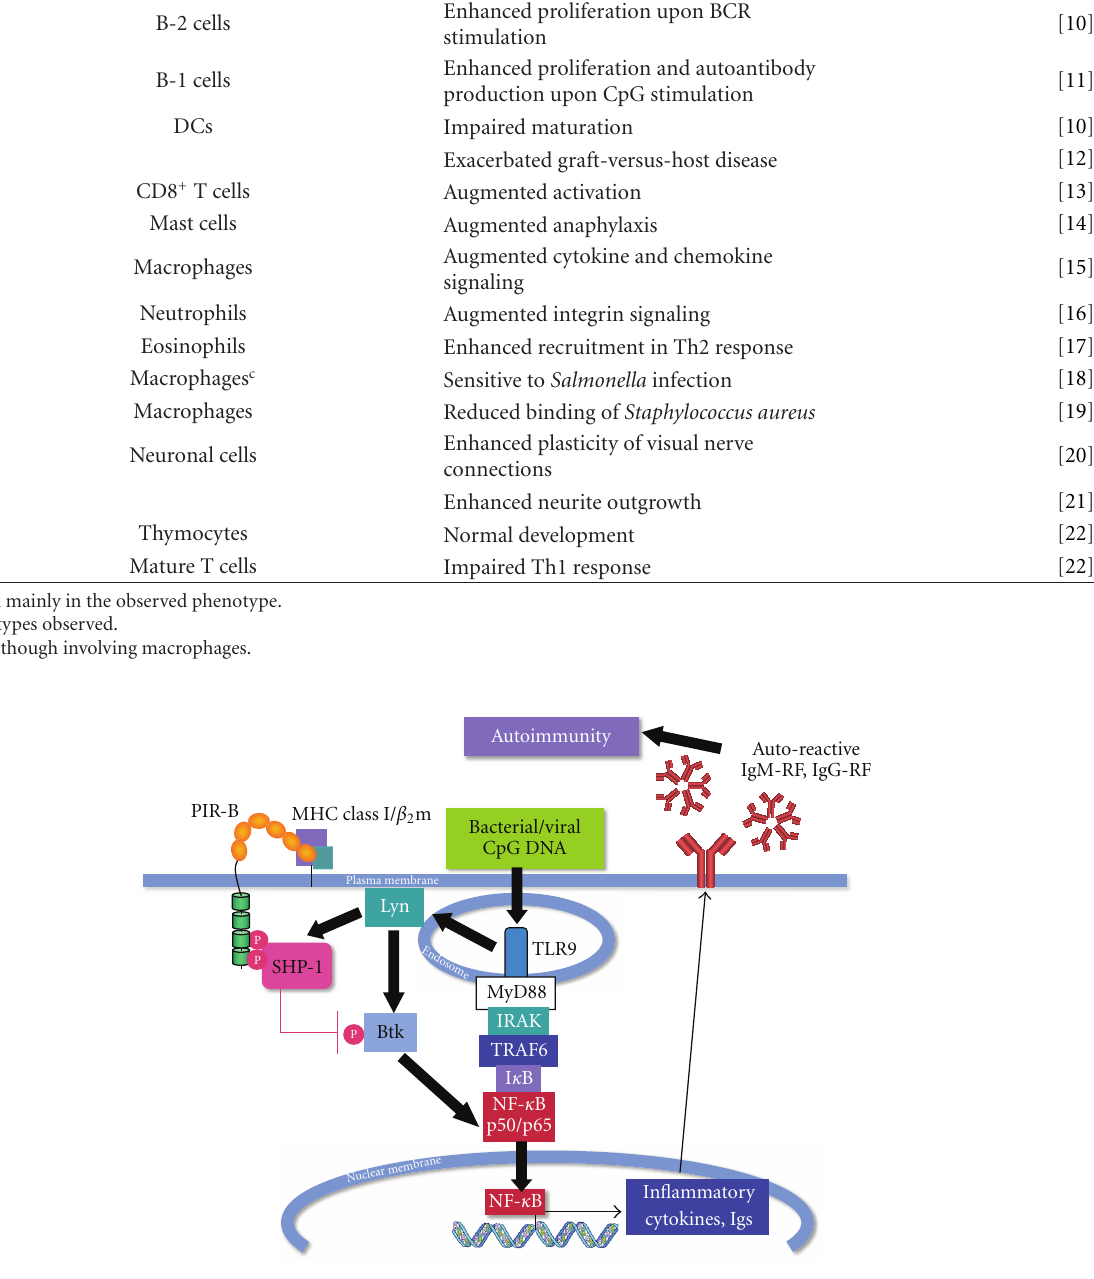
Figure 1: Proposed mechanism for PIR-B-mediated regulation of TLR9-induced autoantibody production in B-1 cells. Unmethylated CpG-harboring DNA of bacterial and viral origin stimulates TLR9 in the endosomal compartments of various cells including B-1 cells via signal relay from MyD88, IRAK, and TRAF6, and then I κ B phosphorylation, nuclear translocation of NF- κ B, and initiation of the transcription of various mRNAs of innate responses, including those for autoreactive natural antibodies. Excess activation of the TLR9 system is thus potentially harmful, because excessive production of autoreactive IgM and, particularly, that switched to IgG might cause autoimmune disease. TLR9 in B-1 cells is regulated by PIR-B via Btk intersection, in which the phosphorylation of PIR-B is augmented immediately through TLR9-initiated Lyn activation, and the concomitantly enhanced SHP-1 recruitment to the phospho-ITIMs of